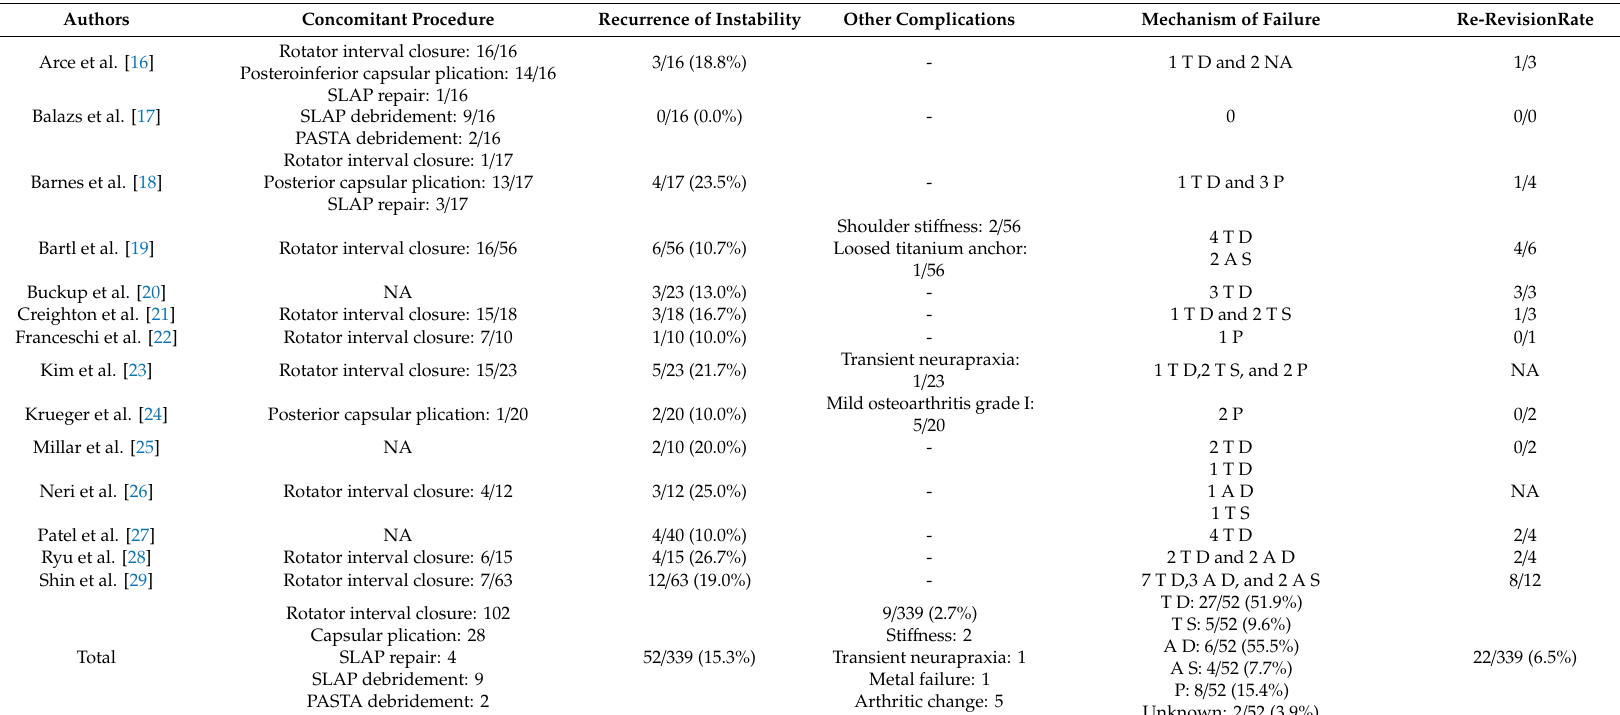
Table 4. Concomitant procedure and complications after revision